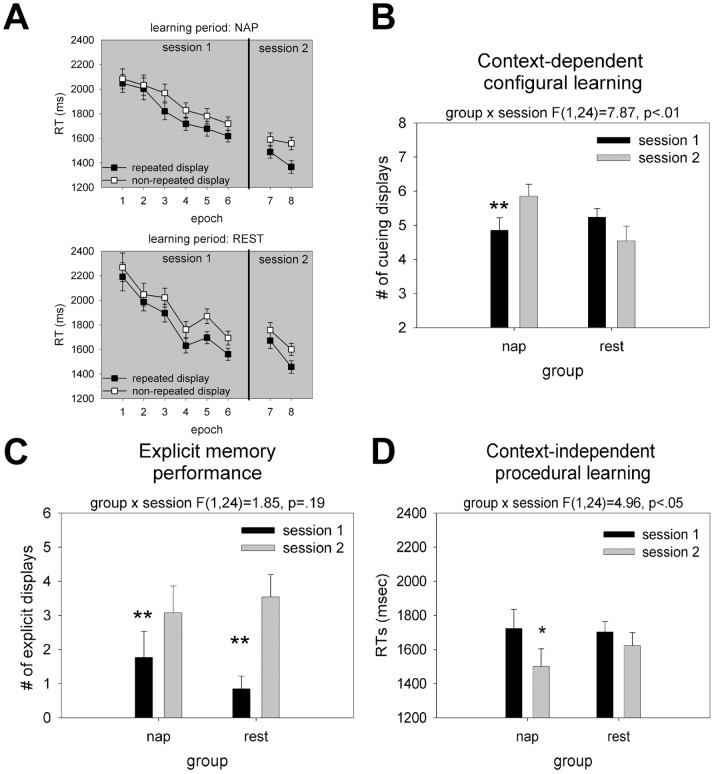
Behavioral performance on the contextual task.
A: Mean RTs and associated standard errors in the nap (top half) and rest (bottom half) group, for epochs 1–6 (first session) and epochs 7–8 (second session), separately for repeated and non-repeated displays. B: Context-dependent configural learning in the nap and rest group. The number of cueing displays is indicated by the black and grey bars, for epochs 4–6 and 7–8, respectively. C: Explicit memory performance in the nap and rest group. The number of explicitly remembered displays is indicated by the black and grey bars, for epochs 4–6 and 7–8, respectively. D: Context-independent procedural learning in the nap and rest group. RT are indicated by the black and grey bars, for epochs 4–6 and 7–8, respectively. In B,C better performance is indicated by higher scores; in A,D better performance is represented by lower scores.